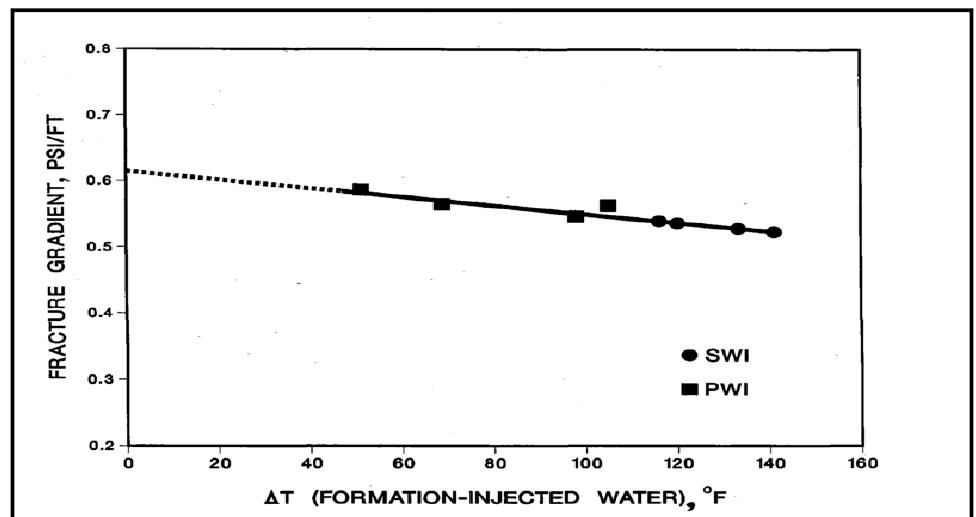
Figure 3. Impact of temperature on the fracture gradient of the Prudhoe Bay field [7].